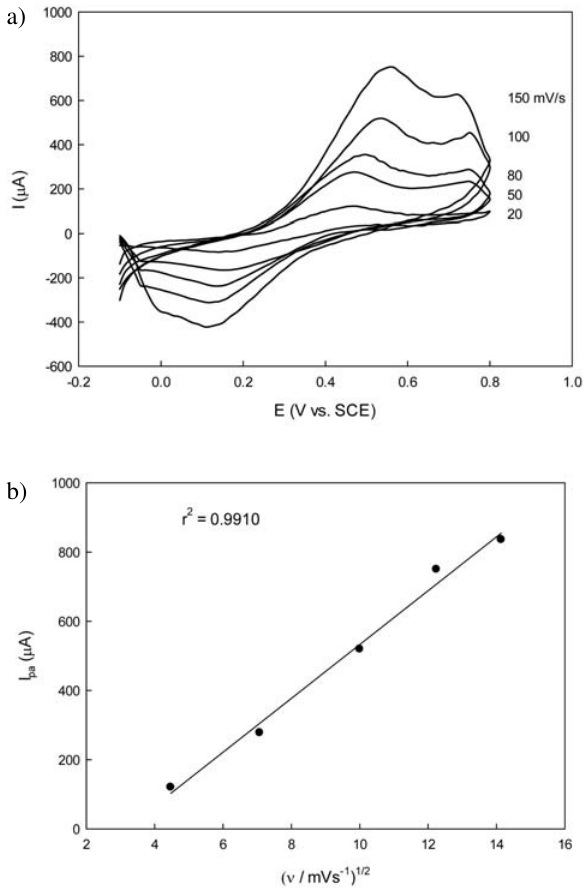
Figure 2. (a) Effect of scan rate on CV for Pt/PAAQ-SDS modified electrode in a phosphate buffer solution at pH 5.0 containing 2.0 mM of catechol at 20, 50, 80, 100, 150, and 200 mV s –1 . (b) Linear behavior of I as a function of scan rate for electro-chemical res- pa ponse of polymer